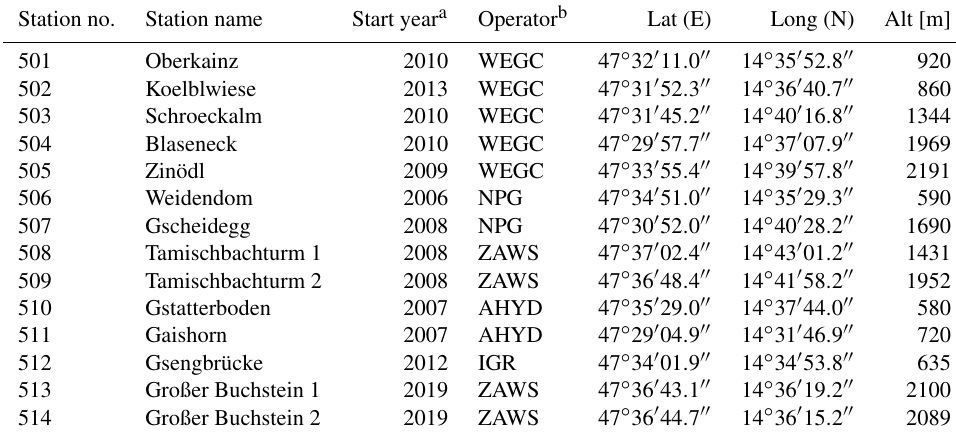
Table 2. Characteristics of the WegenerNet Johnsbachtal (JBT) stations. Station